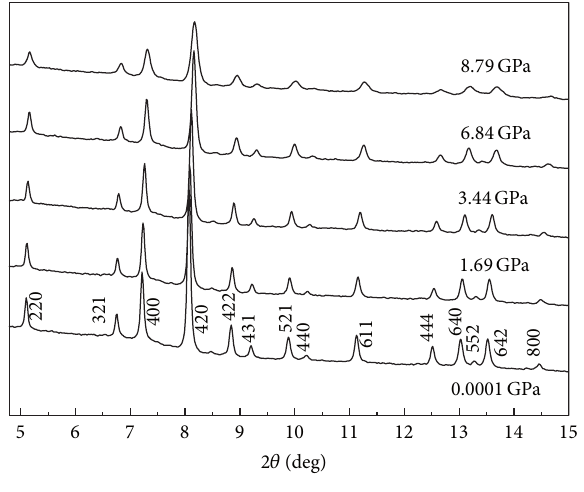
Figure 2: Representative X-ray diffraction patterns of Mg 3 Y 2 (SiO 4 ) 3 up to 8.79 GPa.